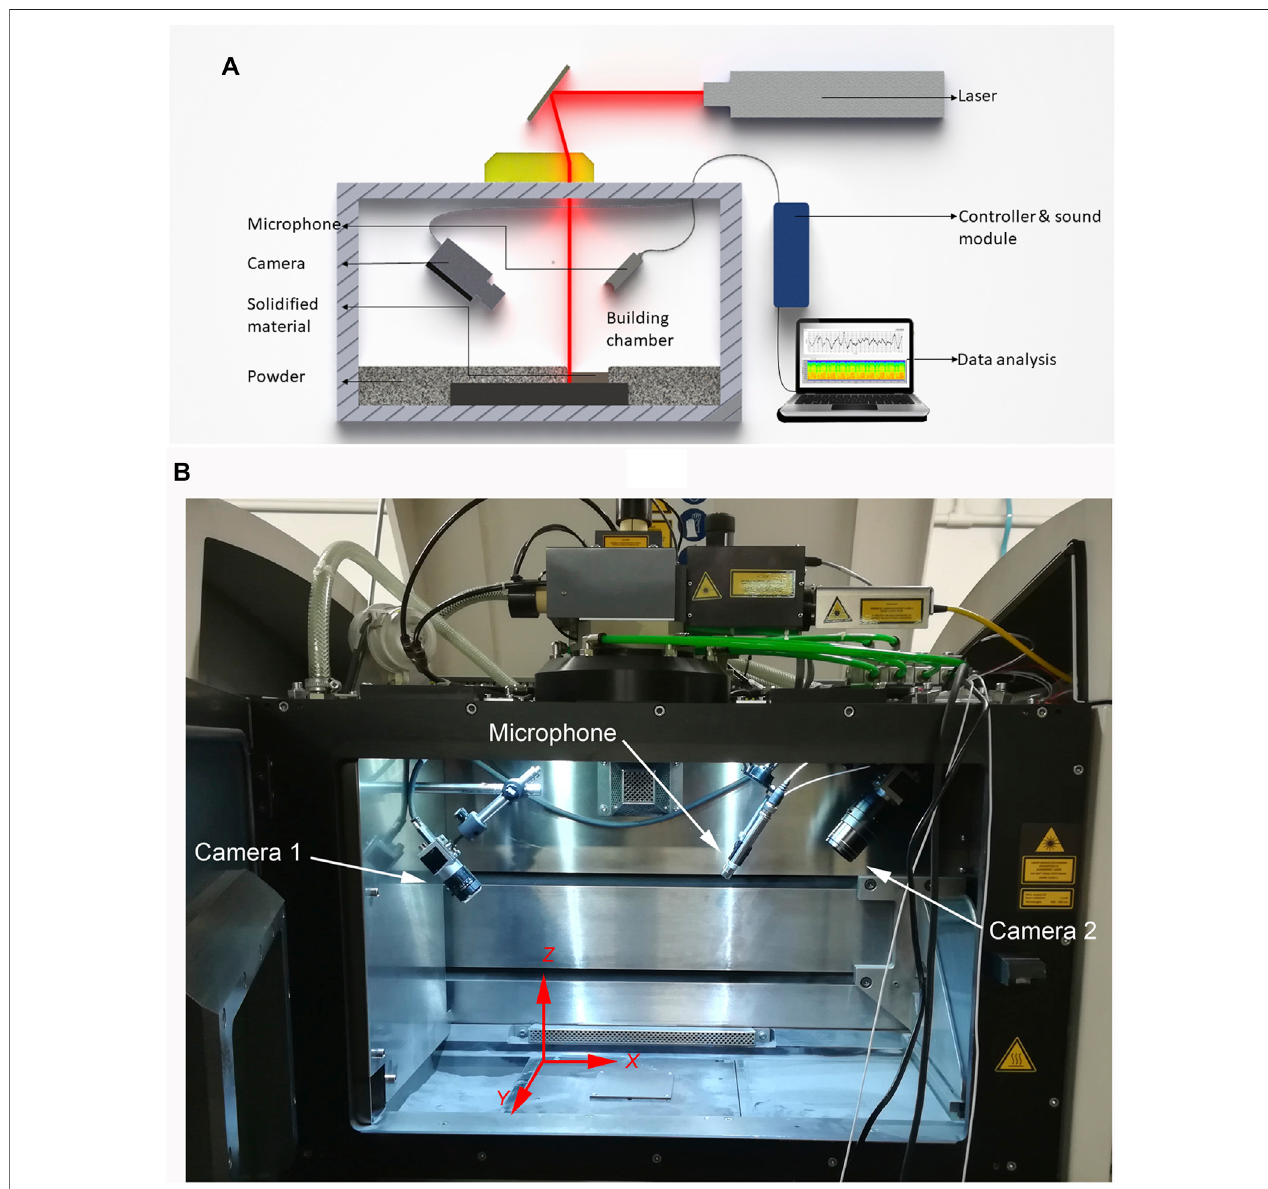
FIGURE2| Schematicofexperimentalsetup (A) andbuildingchamberviewshowingthelocationofthemicrophoneandcameras (B) .Thelaserscanningdirection is along the Y axis; Ar also fl ows in the positive Y direction.